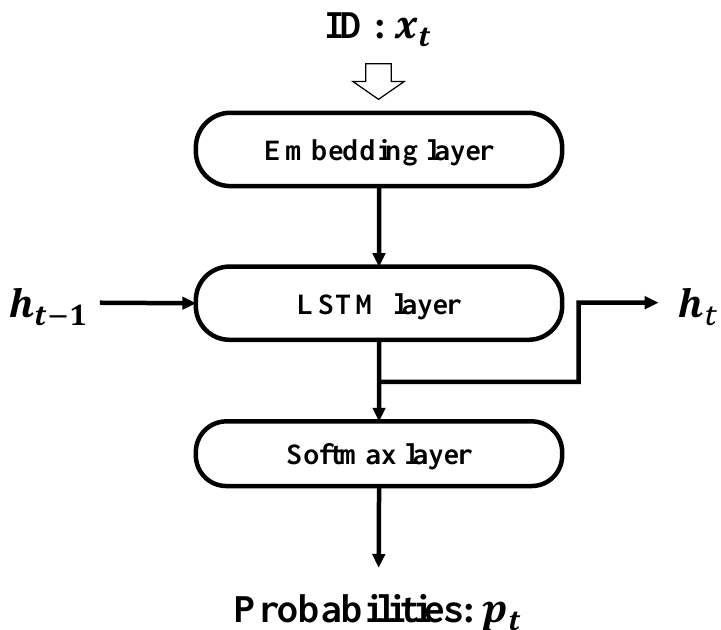
Figure 2. LSTM language model